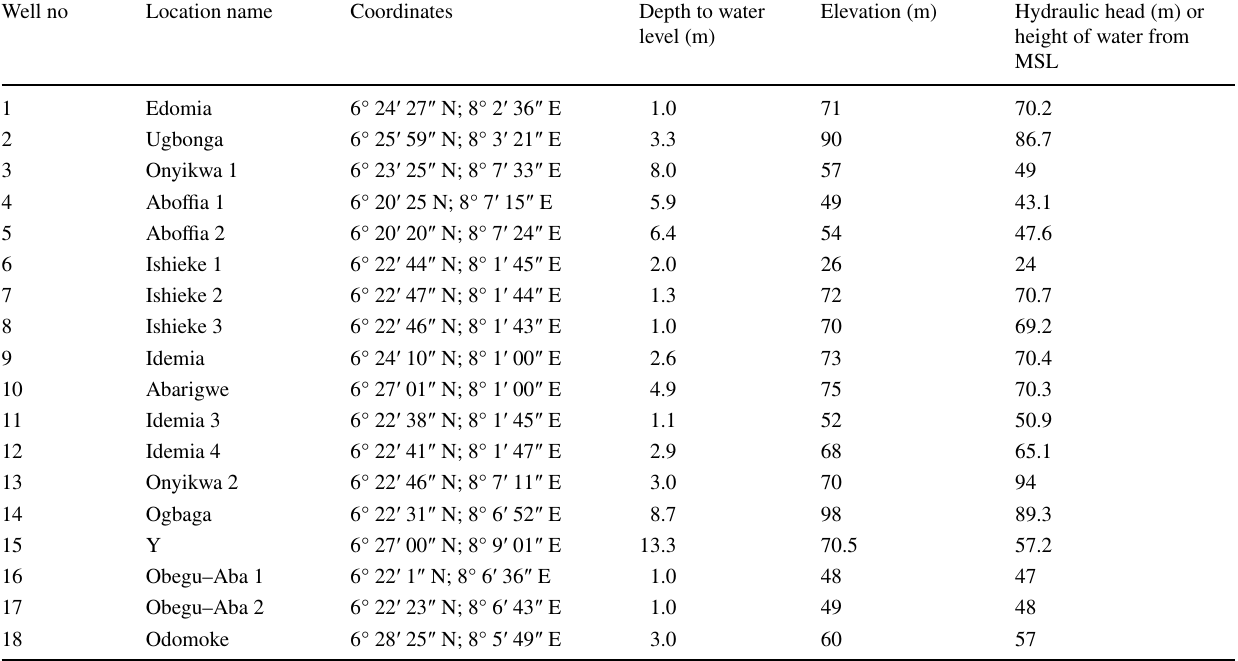
Table 6 Results of the water level